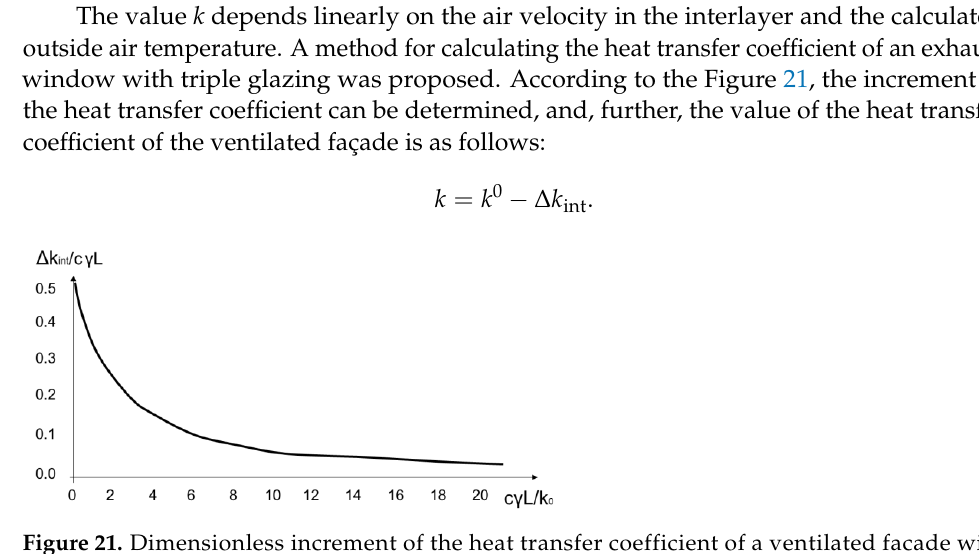
Figure 21. Dimensionless increment of the heat transfer coefficient of a ventilated facade with triple glazing.